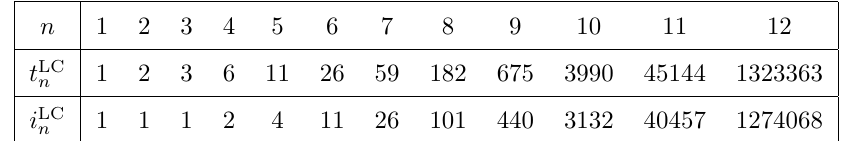
Table 2 . Number of classes of graphs equivalent under local complementation (LC) t LC Number of LC equivalence classes of indecomposable graphs i LC